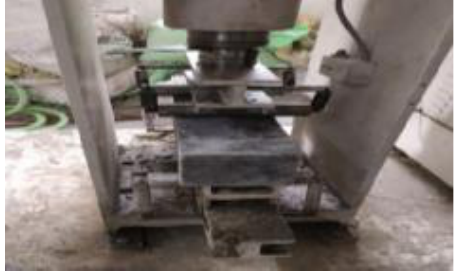
Fig. 19. Flexural Strength